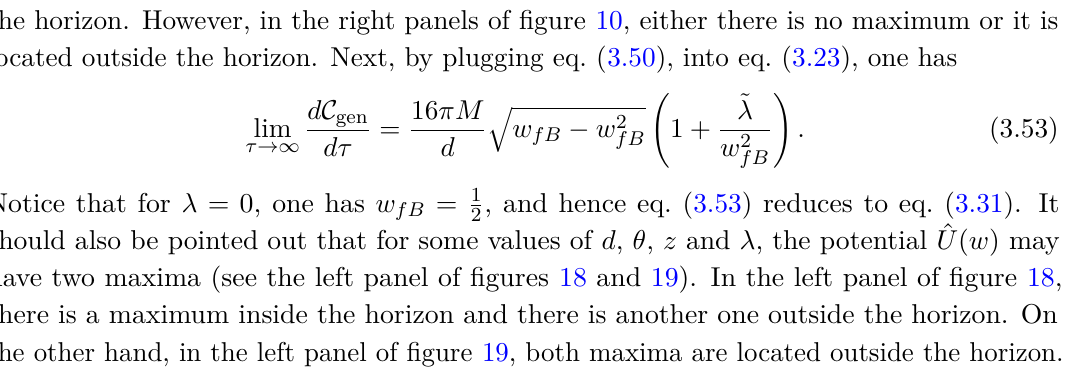
(cid:16) (cid:17) d e + z ˆ for θ = 0 , z = 1 and different r Figure 10 . The effective potential U ( w ) as a function of w = r h values of d and λ . Left ) when λ = 0 , 0 < ˜ λ < λ and − 1 < ˜ λ < 0 , there is a local maximum w crt, 1 fB inside the horizon (see table 4). Right ) when ˜ λ > λ and ˜ λ < − 1 there are two maxima w crt, 2 fA 1 ˜ and w which are located outside the horizon (see tables 1 and 3). For λ λ < λ crt, 2 there fB crt, 1 < is no maximum. In the first row d = 2 and in the second row d = 3 . Notice that for d = 2 , 3 one has ˜ λ = 12 λ and ˜ λ = 72 λ , respectively. We also plotted the case λ = 0 , i.e. the volume-complexity, which is indicated by the dashed black curve. We set L = r = r = 1 . Since for these values of θ h F and z , the HV black brane becomes a planar AdS-Schwarzschild black hole, these figures are the same as figure 3 in ref.